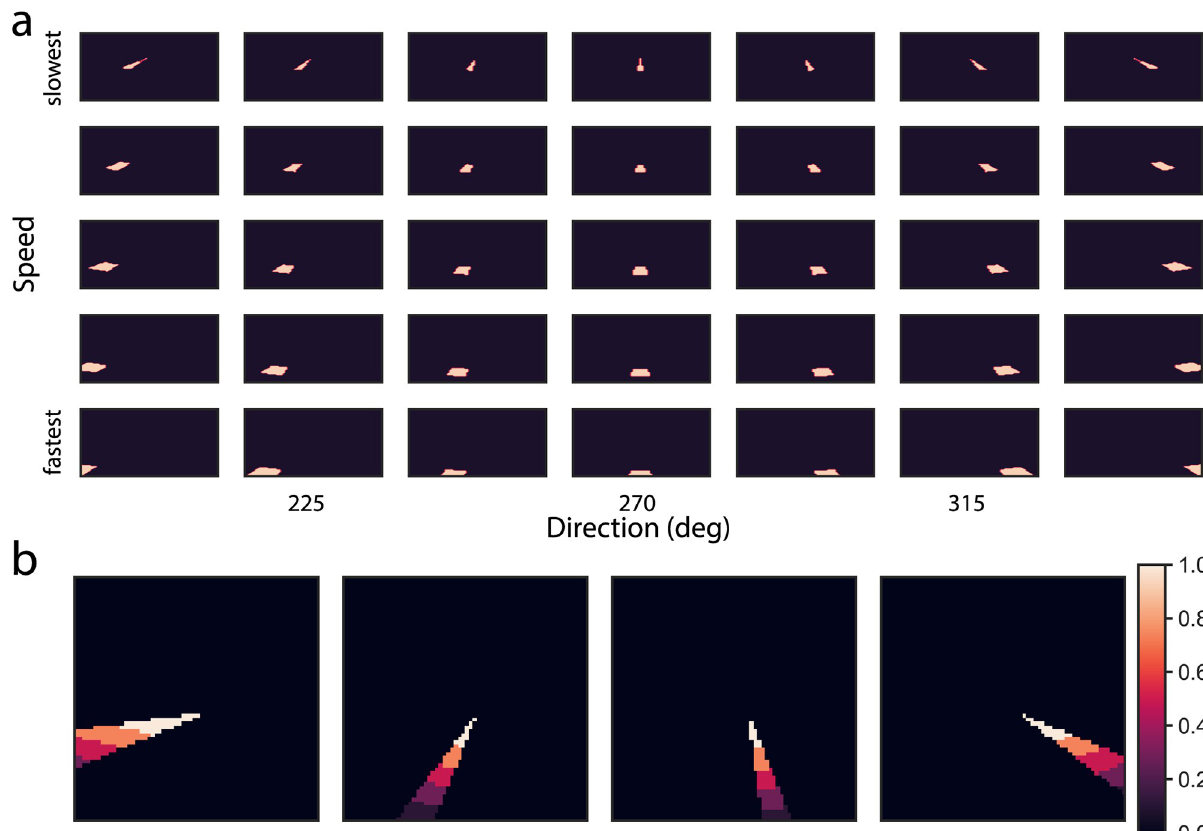
Fig 8. MSTd ground units. (a) Regions of a ground unit’s RF tuned to a central heading that exhibit maximal sensitivity to the indicated MT + speeds and directions. (b) Connection weights among the different speed-tuned inputs along a subset of the directions for the slowest speed subunit. Weights shown prior to